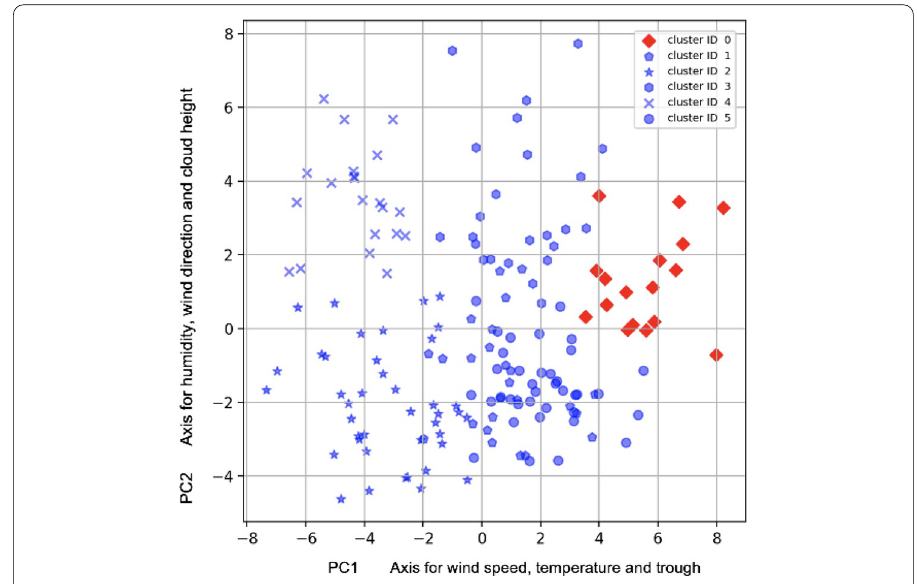
Fig. 7 Six clusters obtained via the k-means method